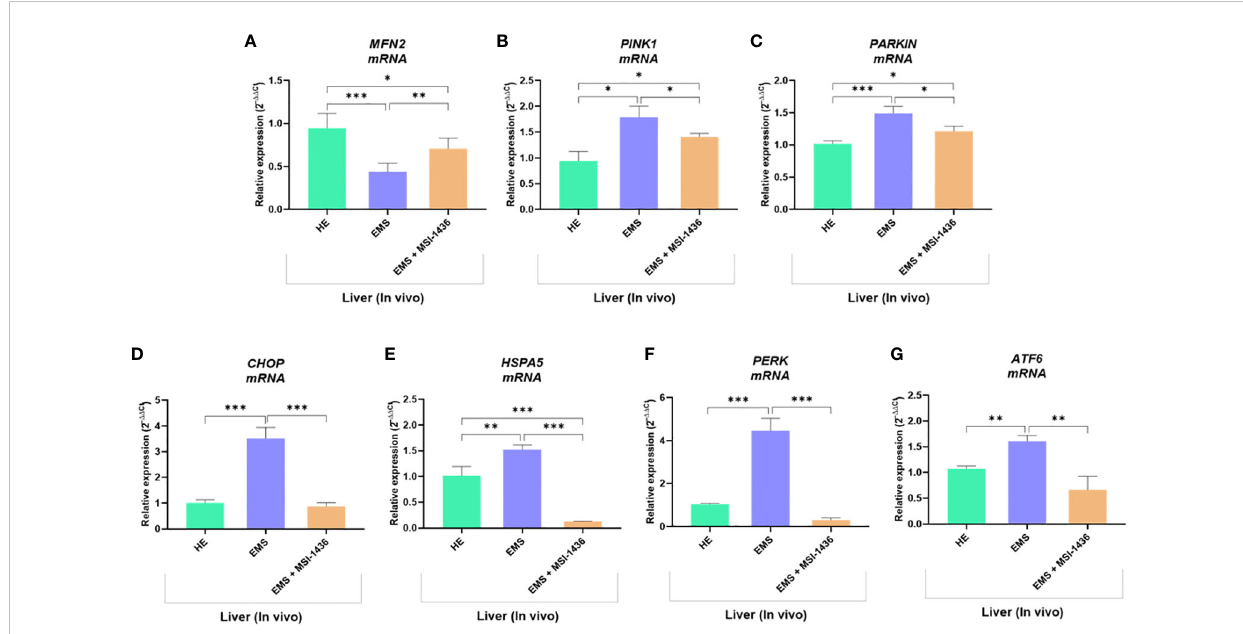
FIGURE 10 Impact of MSI-1436 administration on key mitochondrial dynamics and ER stress related markers expression in EMS affected horses. Relative gene expression of Mitochondrial dynamics (A, B, C) and ER stress (D, E, F, G) mediators analysed using RT-qPCR technique. Data are presented as a mean value obtained from measurments ± SD. Statistical signi fi cance was marked as follows: *p-value < 0.05; **p < 0.01 and ***p-value <